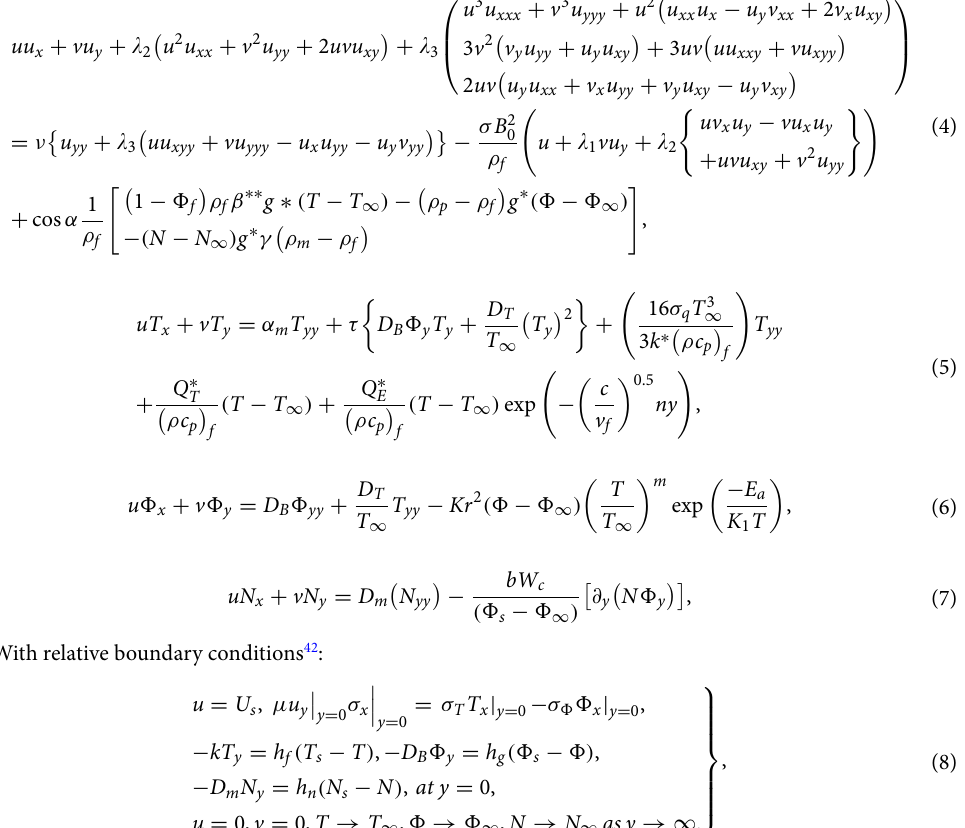
rations ( (cid:31) 3 ) is the retardation effect and ( (cid:31) 1 & (cid:31) 2 ) are relaxation effects. It is marked out here that the outcomes for the Oldroyd-B fluid model can be deduced for ( (cid:31) 2 (cid:31) reduced ( (cid:31) 2 3 = 0 ) . Also, the effects of the Fluid model can be extracted by specifying ( =